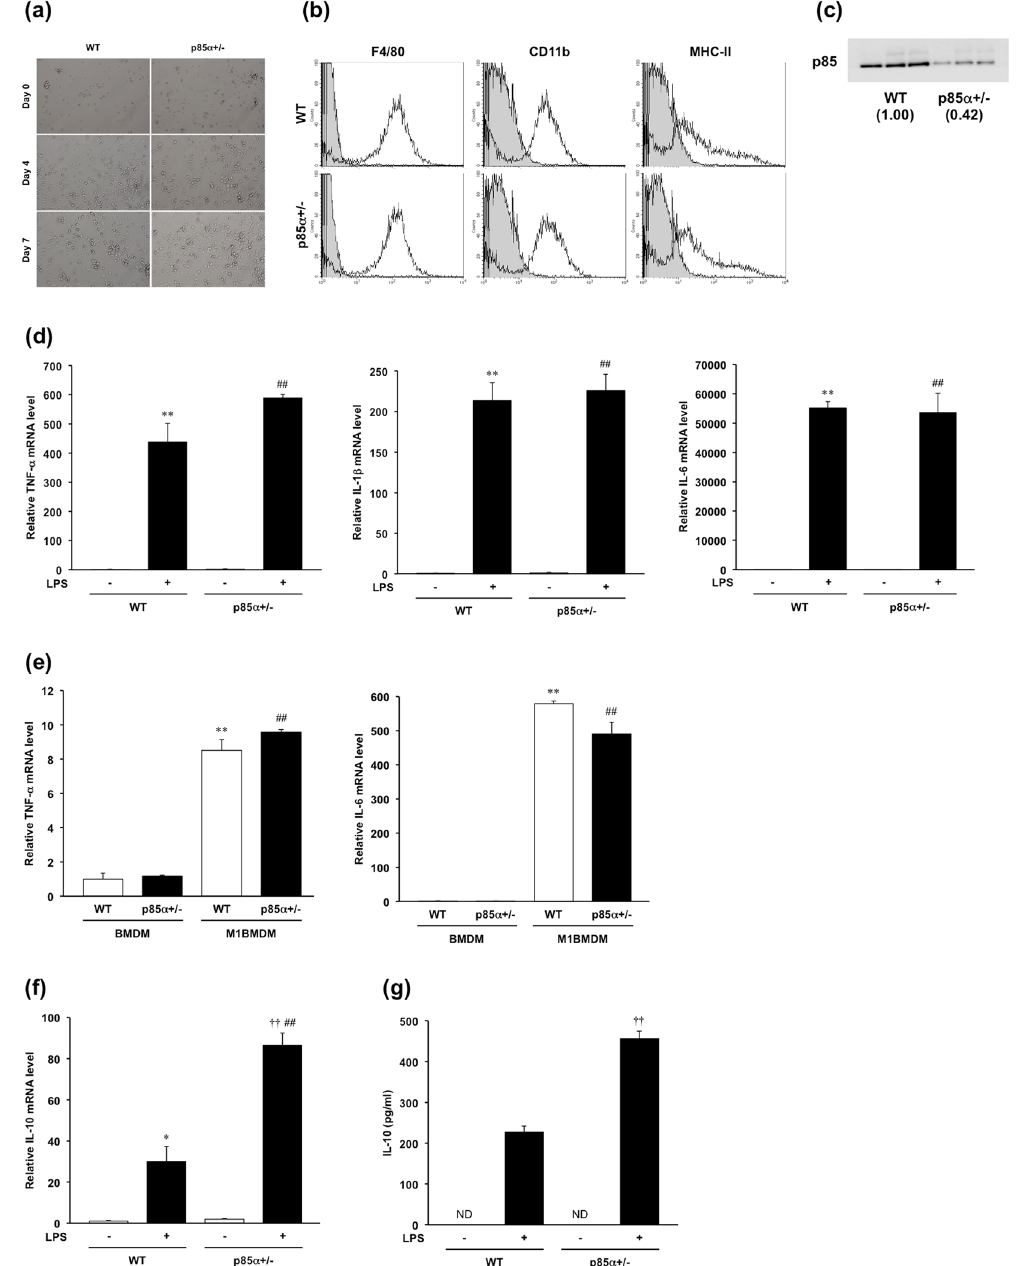
Figure 3. p85 α -deficient macrophages produce a large amount of IL-10. BMDMs were prepared from the femurs and tibiae of WT or p85 α+ / − mice and cultured with M-CSF (100 ng/ml) for 7 days. ( a ) Representative images of BMDM morphology. ( b ) Representative flow cytometry histogram. ( c ) Representative images of PI3K p85 α protein expression in WT or p85 α+ / − BMDMs as detected by western blotting. ( d ) Proinflammatory mediator mRNA expression in BMDMs from WT or p85 α+ / − mice. BMDMs were stimulated with LPS (100 ng/ml) for 4 h. ( e ) Proinflammatory cytokine mRNA expression in M1BMDMs from WT or p85 α+ / − mice. ( f ) IL-10 mRNA expression in BMDMs from WT or p85 α+ / − mice. BMDMs were stimulated with LPS (100 ng/ml) for 4 h. ( g ) The concentration of IL-10 in the culture supernatants of BMDMs. BMDMs were stimulated with LPS (100 ng/ml) for 24 h, and the culture supernatant was analyzed for IL-10 protein using a CBA kit. The data are presented as the mean ± SE of 4 independent experiments. * p < 0.05; ** p < 0.01, compared with WT BMDM LPS ( − ). †† p < 0.01, compared with WT BMDM LPS ( + ). ## p < 0.01, compared with p85 α+ / − BMDM LPS ( −